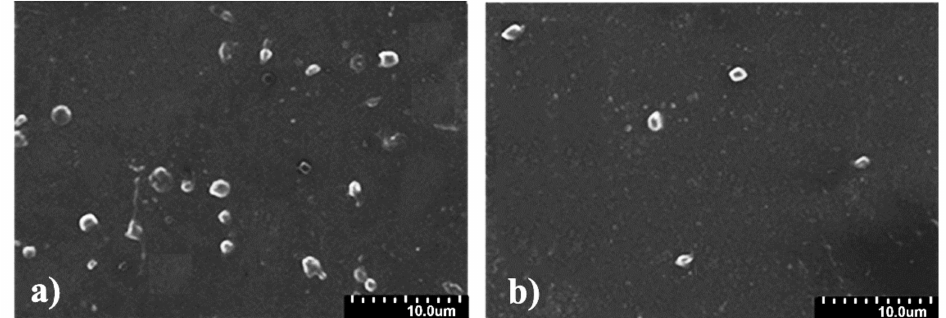
Figure 7. Typical SEM images of platelet adhesion on the film surface of ( a ) SPU and ( b )